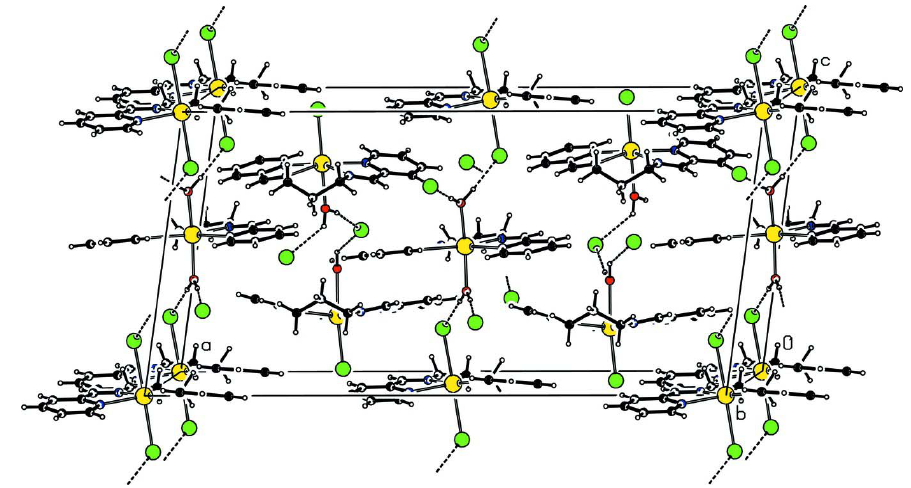
Figure 1 The structure of the title compound. Displacement ellipsoids are drawn at the 30% probability level.